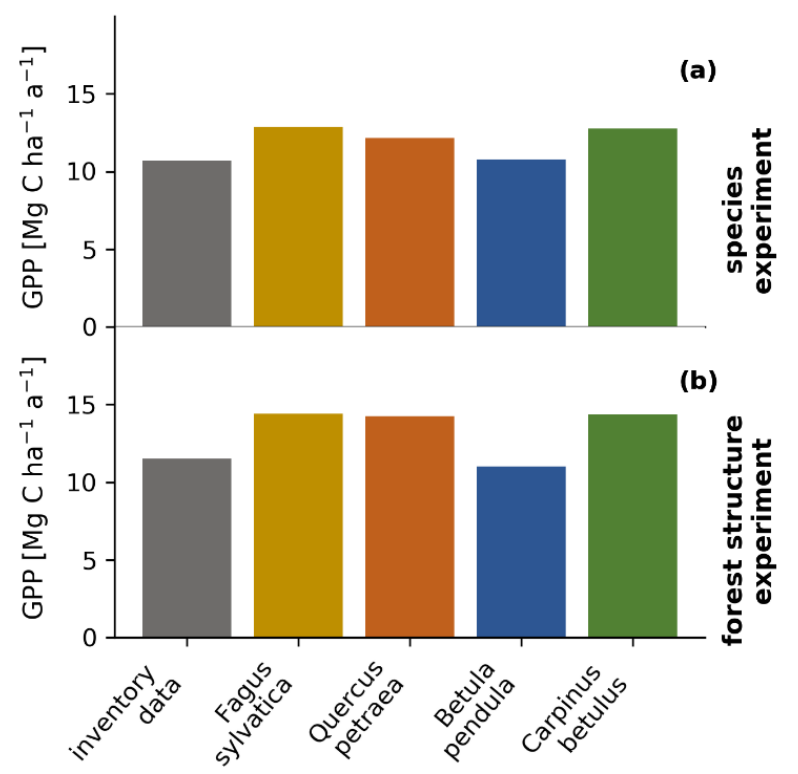
Figure 5. Simulated productivity of medium-sized trees for two virtual experiments with ( a ) the species experiment based on monocultures for each of the species (coloured bars) and ( b ) the forest structure experiment without large trees (only trees with a dbh less than 60 cm). Both experiments are compared with the simulation results of the full inventory data (grey bars). For comparison with the forest structure experiment, all trees with a dbh > 60 cm were excluded. Virtual experiments are explained in Section 2.7.